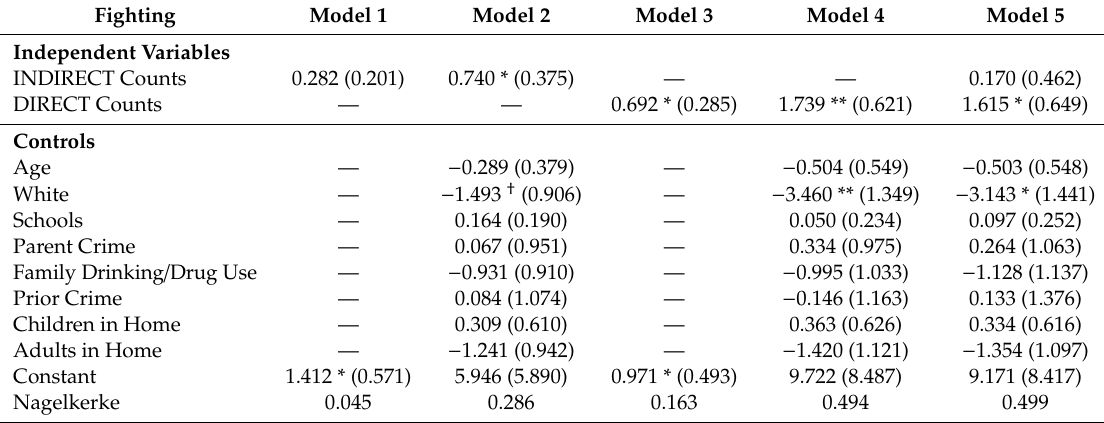
Table 3. The e ff ect of indirect and direct victimization counts on